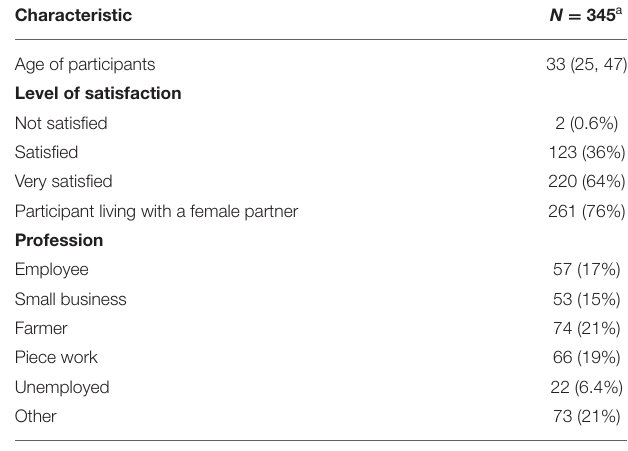
TABLE 3 | Special day participants characteristics (Balaka).